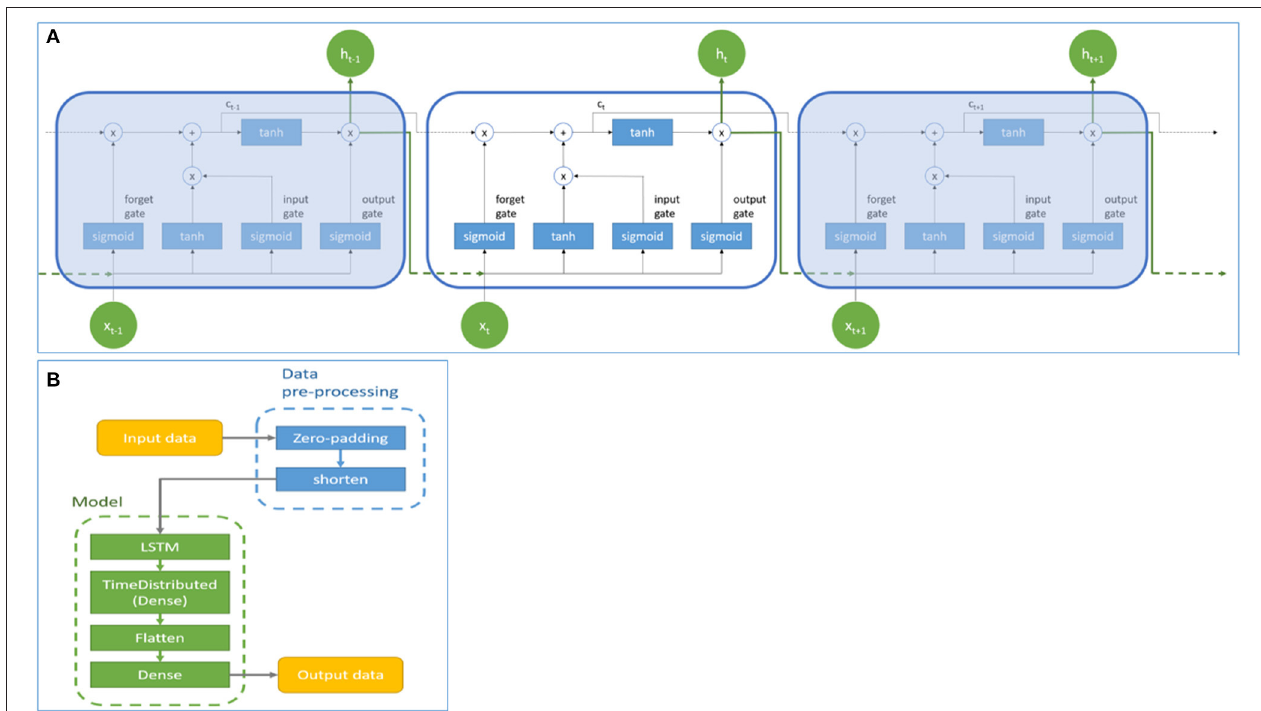
FIGURE 1 | The basic architecture (A) and data pre-processing and architectural flow (B) of the Long Short-Term Memory model. Symbol x and h represent the input and output values of the LSTM cell. Symbol c represents the value of the memory cell in each LSTM cell. Subscript t represents the time step.